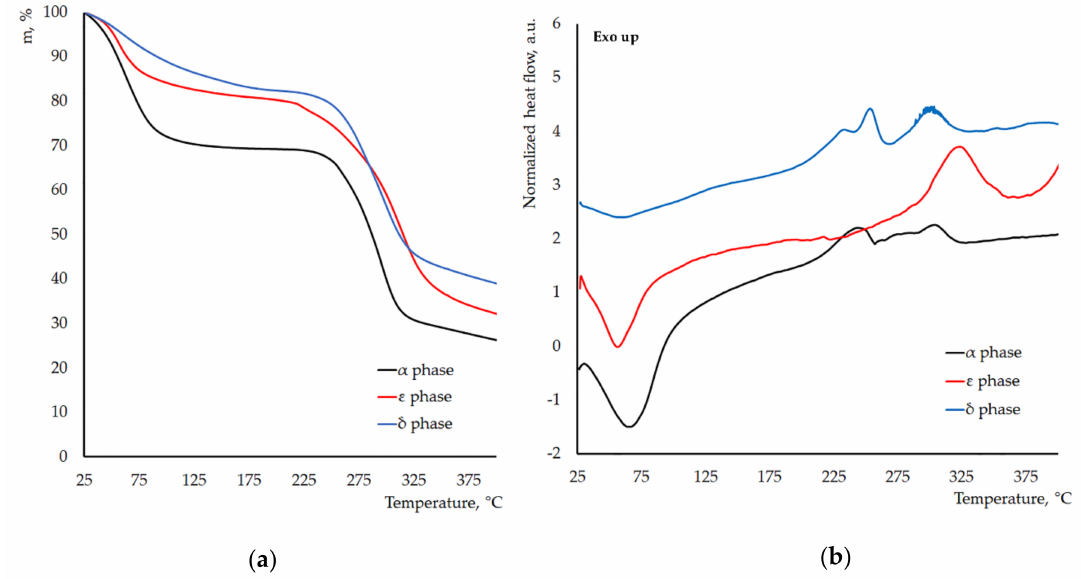
Figure 9. ( a ) TGA and ( b ) DSC curves of γ -CD-MOF-1 crystalline phases.